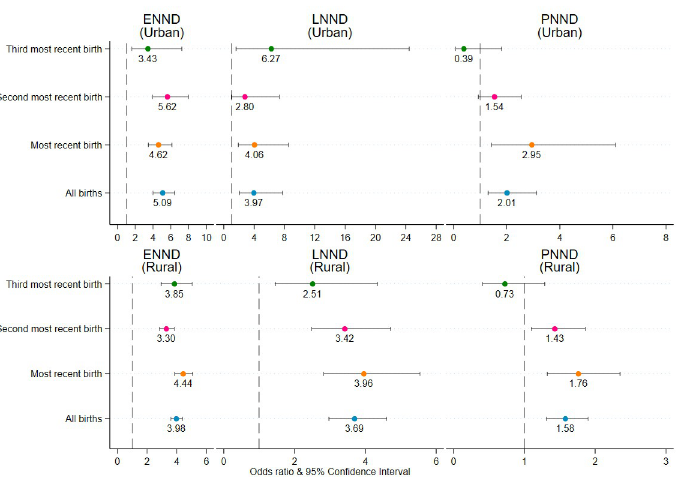
Fig 5. Adjusted odds ratio of ENND, LNND, and PNND for preterm birth stratified by urban-rural residence, NFHS-4, 2015–16. Note. 1. Odds ratios are significant at p < 0.05. ENND Early Neonatal Death, LNND Late Neonatal Death, PNND Post Neonatal Death. Odds ratio are adjusted for birth order, index child c-section, index birth wanted, sex of child mother’s age at conception, mother’s height, mother’s schooling, caste, religion, wealth quintiles, and state- region.